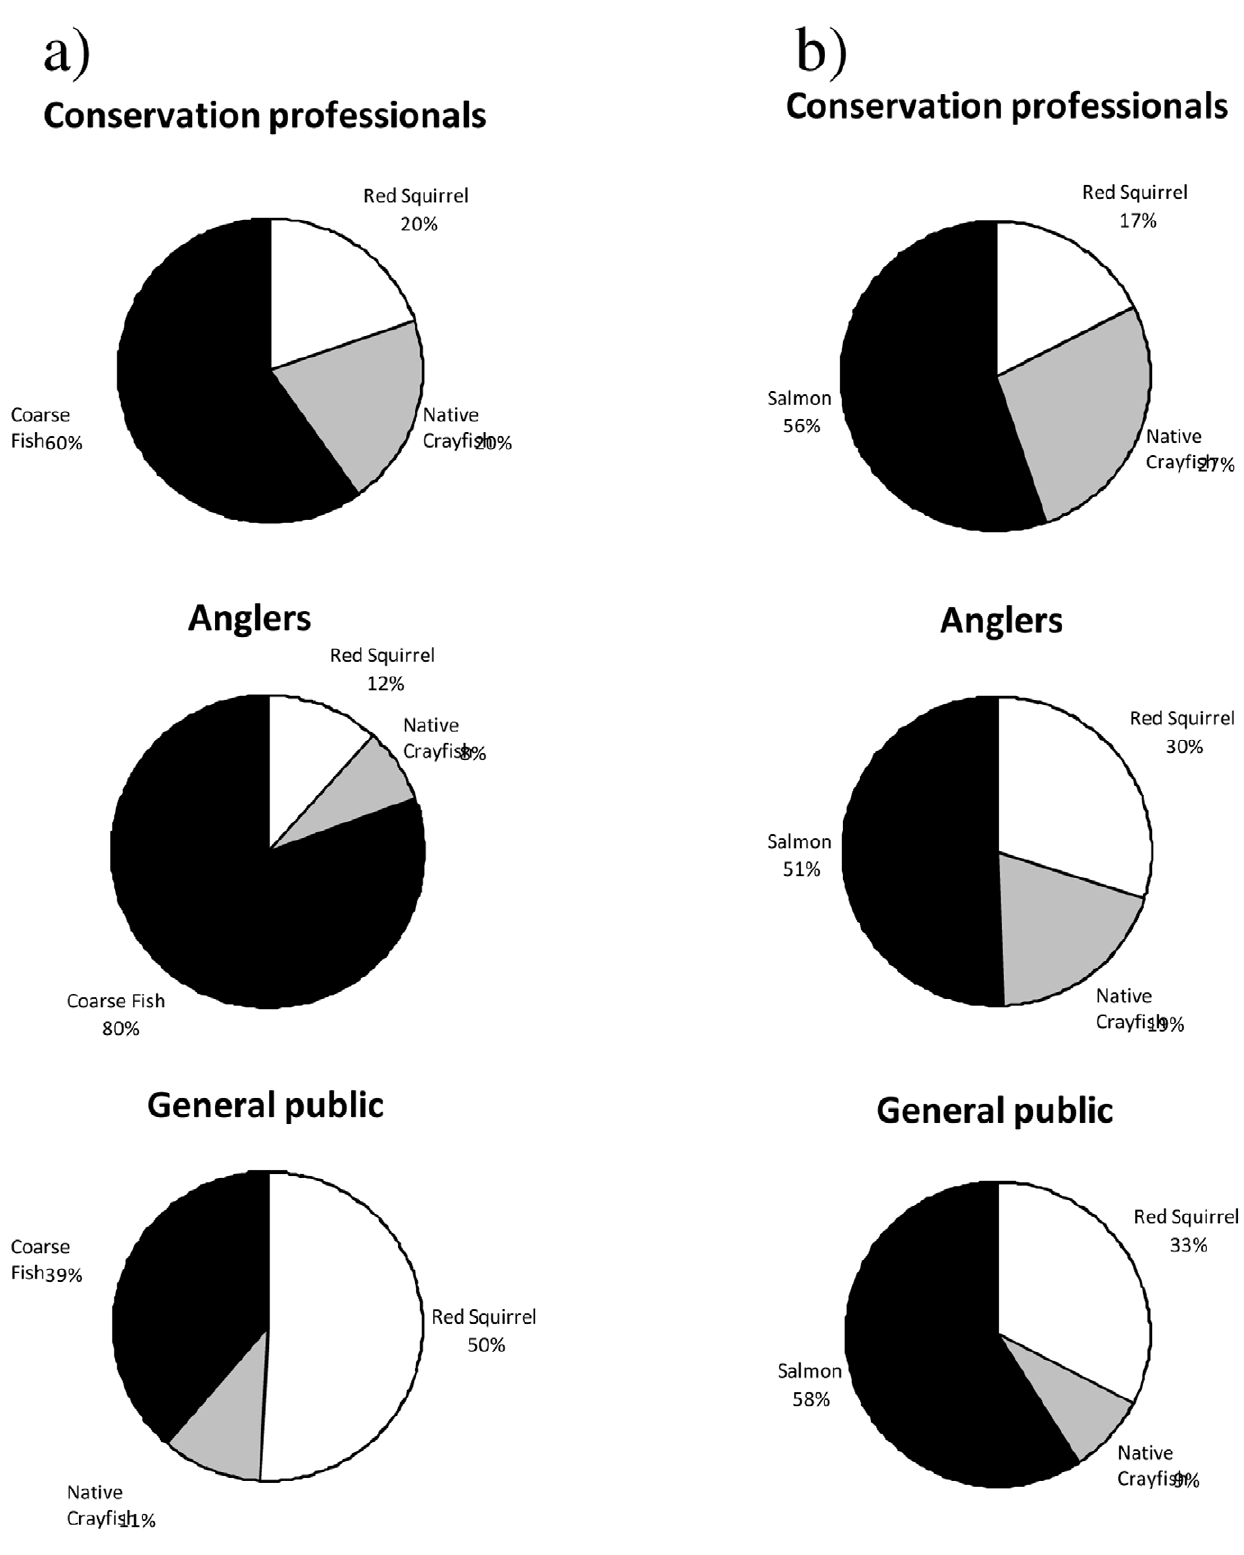
Figure 2. Evaluation of UK conservation concerns. Conservation managers (n=132), public respondents (n=186) and anglers (n=103) were asked to select one species from a range, (a) red squirrel, native crayfish or coarse fish, (b) red squirrel, native crayfish or salmon, for which a disease to, would cause the most ecological concern.